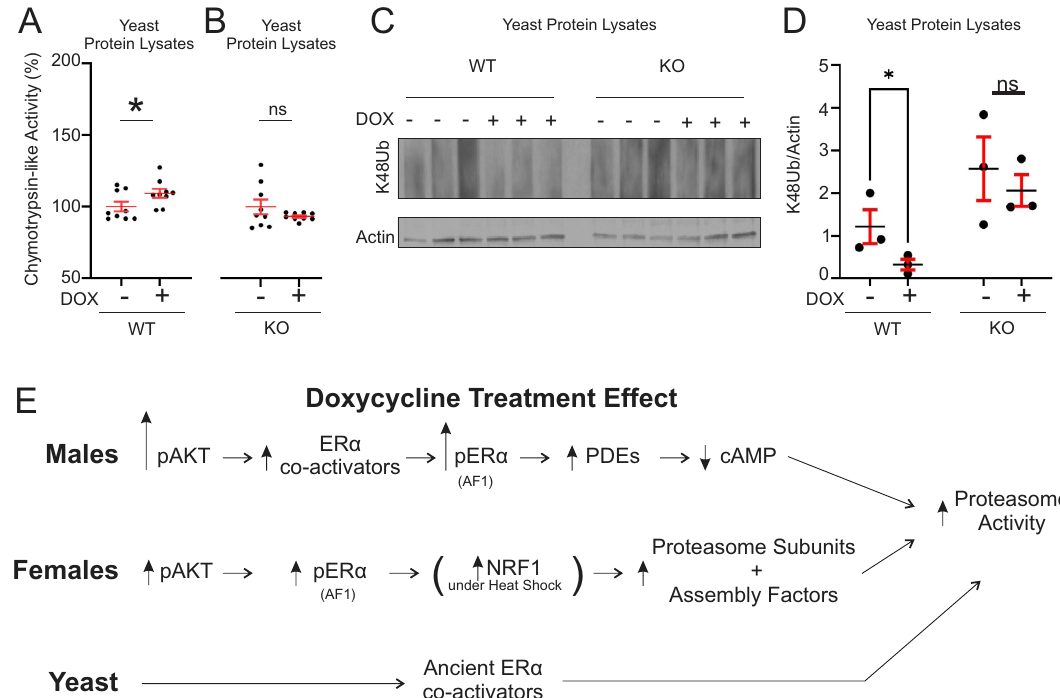
Figure 5. Doxycycline activates the proteasome in yeast in a Mms19 dependent manner. ( A ) Activity of the proteasome in wild-type yeast cells with and without doxycycline (n = 3 biological replicates with 2–3 technical replicates per culture) after 90 min of treatment values were normalized to the untreated control in both groups. ( B ) Activity of the proteasome in Mms19 knockout yeast cells (mms19Δ) with and without doxycycline. (n = 3 biological replicates with 2–3 technical replicates per culture). ( C ) Western blot of K48Ub-linked proteins in wild-type and mms19Δ yeast cells with and without doxycycline (n = 3 biological replicates). The samples were run on the same gel in the indicated order. ( D ) Quantification of ( C ). ( E ) Model of the proposed differential route of activation of the proteasome in yeast or male and female spinal cords. * or **, indicates p < 0.05 or p < 0.005 by student’s